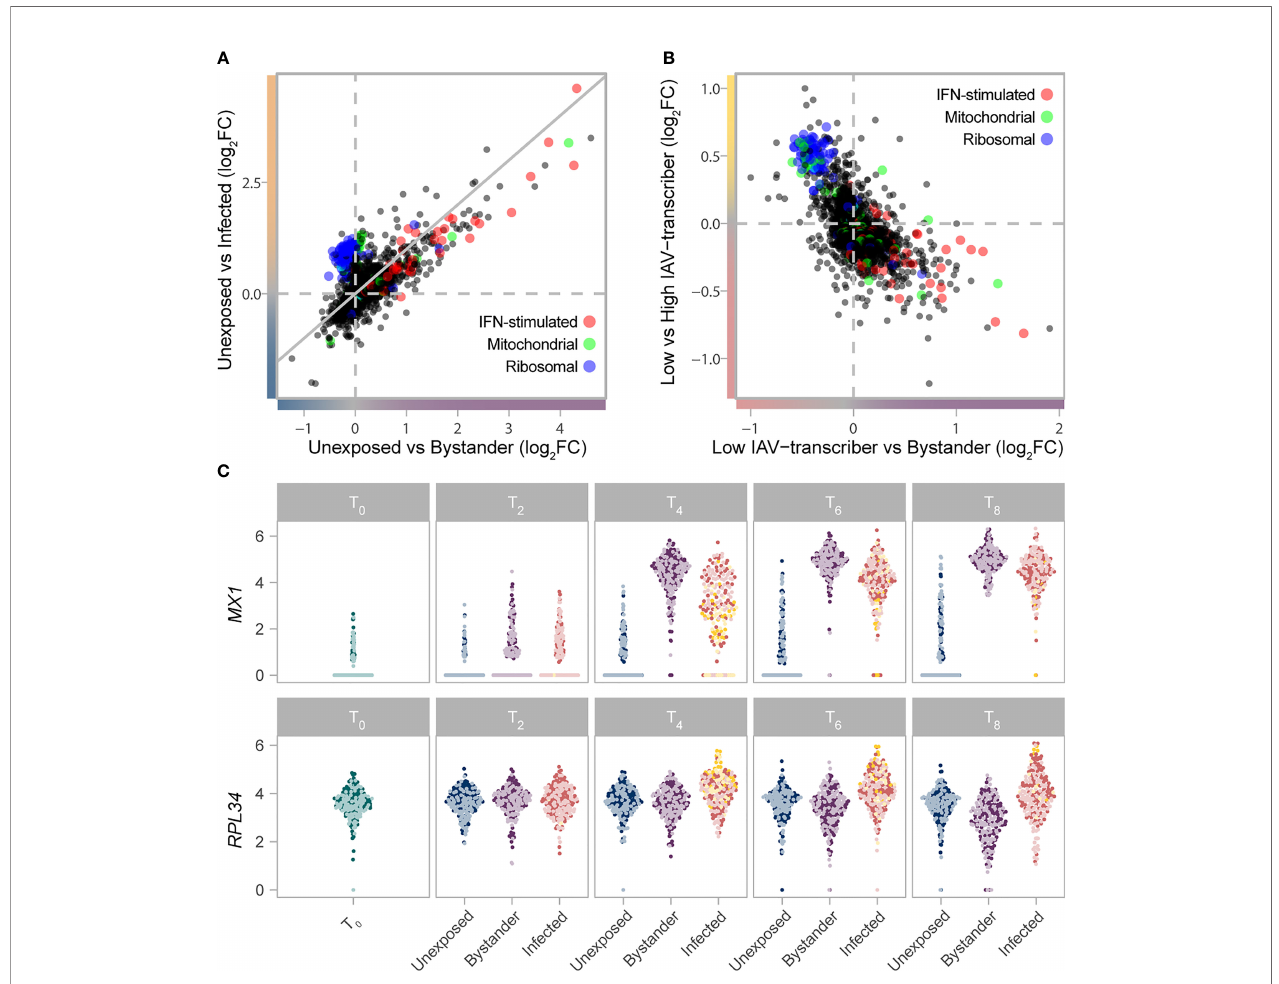
FIGURE 2 | Gradient of mRNA expression from ribosomal and IFN-stimulated genes separates bystander and infected cells. (A) Transcriptional responses of cells upon IAV challenge (T 2 -T 8 ) highlight the interplay between IFN-stimulated (GO:0034340), ribosomal (GO:0005840), and mitochondrial (GO:0005743) genes. The log 2 FC change in gene expression between unexposed and bystander cells is plotted on the x-axis, while the log 2 FC change in gene expression between unexposed and infected cells is plotted on the y-axis. Values are plotted based on a meta-analysis across time points and subsets, of a subsampled dataset with balanced representation of all donors. (B) The interplay between IFN-stimulated (GO:0034340), ribosomal (GO:0005840), and mitochondrial (GO:0005743) genes among cells exposed to IAV. The log 2 FC change in gene expression between low IAV-transcribing infected and bystander cells is plotted on the x-axis, while the log 2 FC change in gene expression between low IAV-transcribing infected and high IAV-transcribing infected cells is plotted on the y-axis. Values are plotted based on a meta-analysis across monocyte subsets at T 4 . (C) mRNA expression levels of representative IFN-stimulated ( MX1 ) and ribosomal ( RPL34 ) genes across the subsampled dataset. Colors re fl ect the cell state and subset assignment depicted in Figures 1D, E . IFN, Interferon; FC, fold